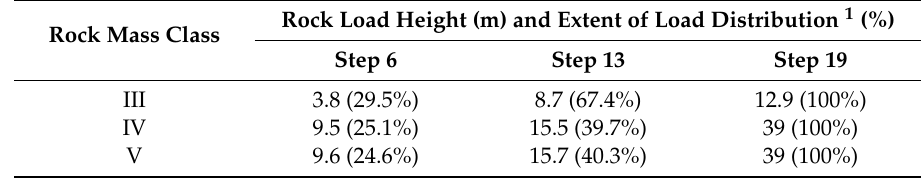
Table 4. Rock load obtained in different rock classifications with respect to the construction steps.